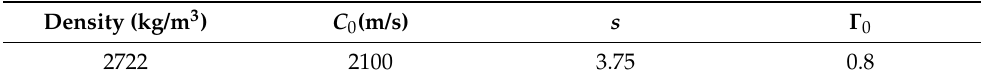
Table 1. Material parameters for STF.